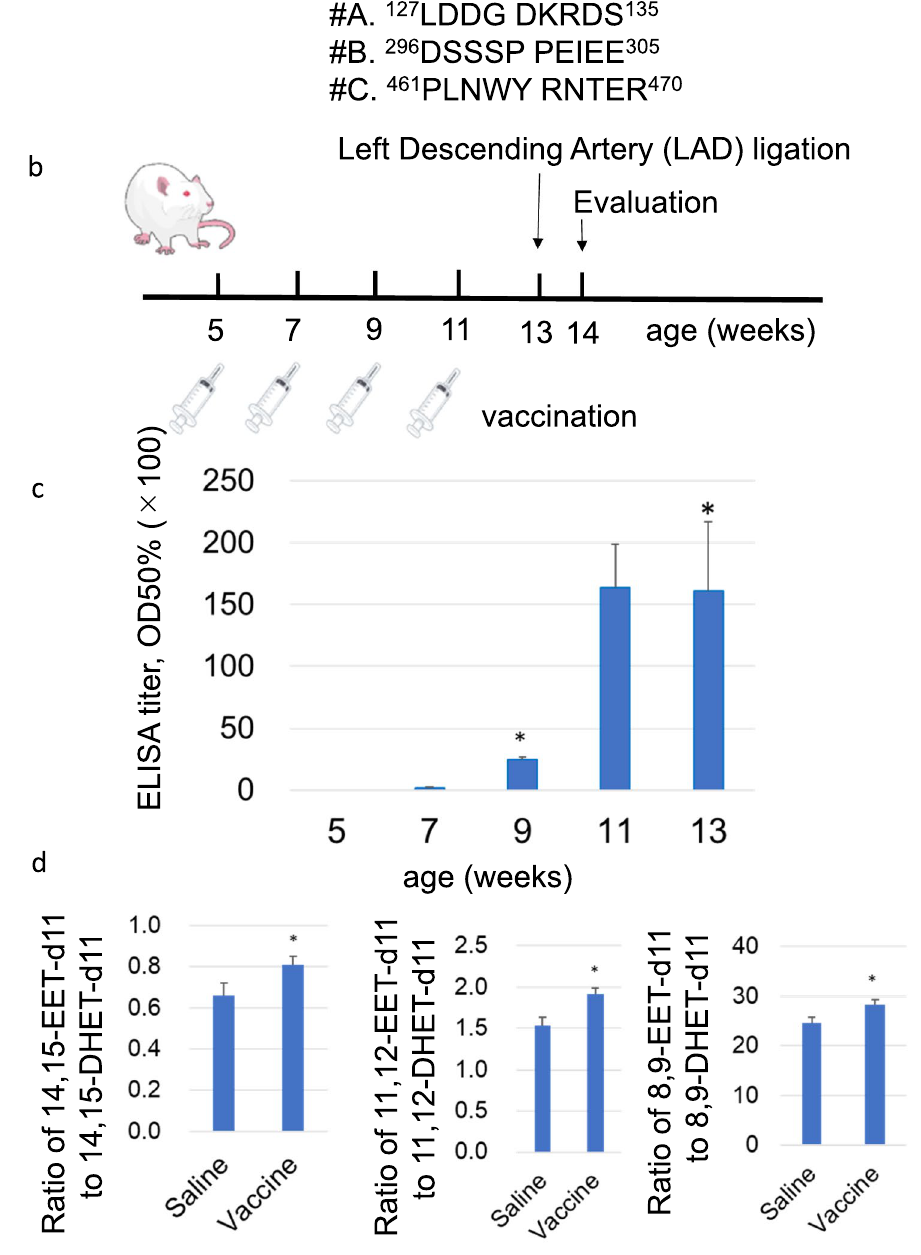
Figure 1. The antibody induced by sEH vaccine inhibited hydrolysis of EETs. ( a ) The peptide sequence of sEH vaccine. ( b ) The protocol of vaccination and evaluation. The sEH vaccine was administered to 5-wk-old rats 4 times at 2-wk intervals. ( c ) Anti-sEH antibody titer was quantified by ELISA. A high half-maximum value was obtained (> 1000) in all four rats after the second vaccination. n = 4. * P < 0.05. ( d ) Blood from rats was collected at 14 wk of age and preserved as plasma . Having th e antibody in the plasma prevented 14,15-EET-d11, 11,12- EET-d11 and 8,9-EET-d11 from being hydrolyzed into 14,15-DHET-d11, 11,12-DHET-d11 and 8,9-DHET-d11 and the ratio of 14,15-EET-d11 to 14,15-DHET-d11, 11,12-EET-d11 to 11,12-DHET-d11 and 8,9-EET-d11 to 8,9-DHET-d11 were increased in the vaccinated group. n = 8 in the control group and n = 9 in the vaccinated group. ** P <